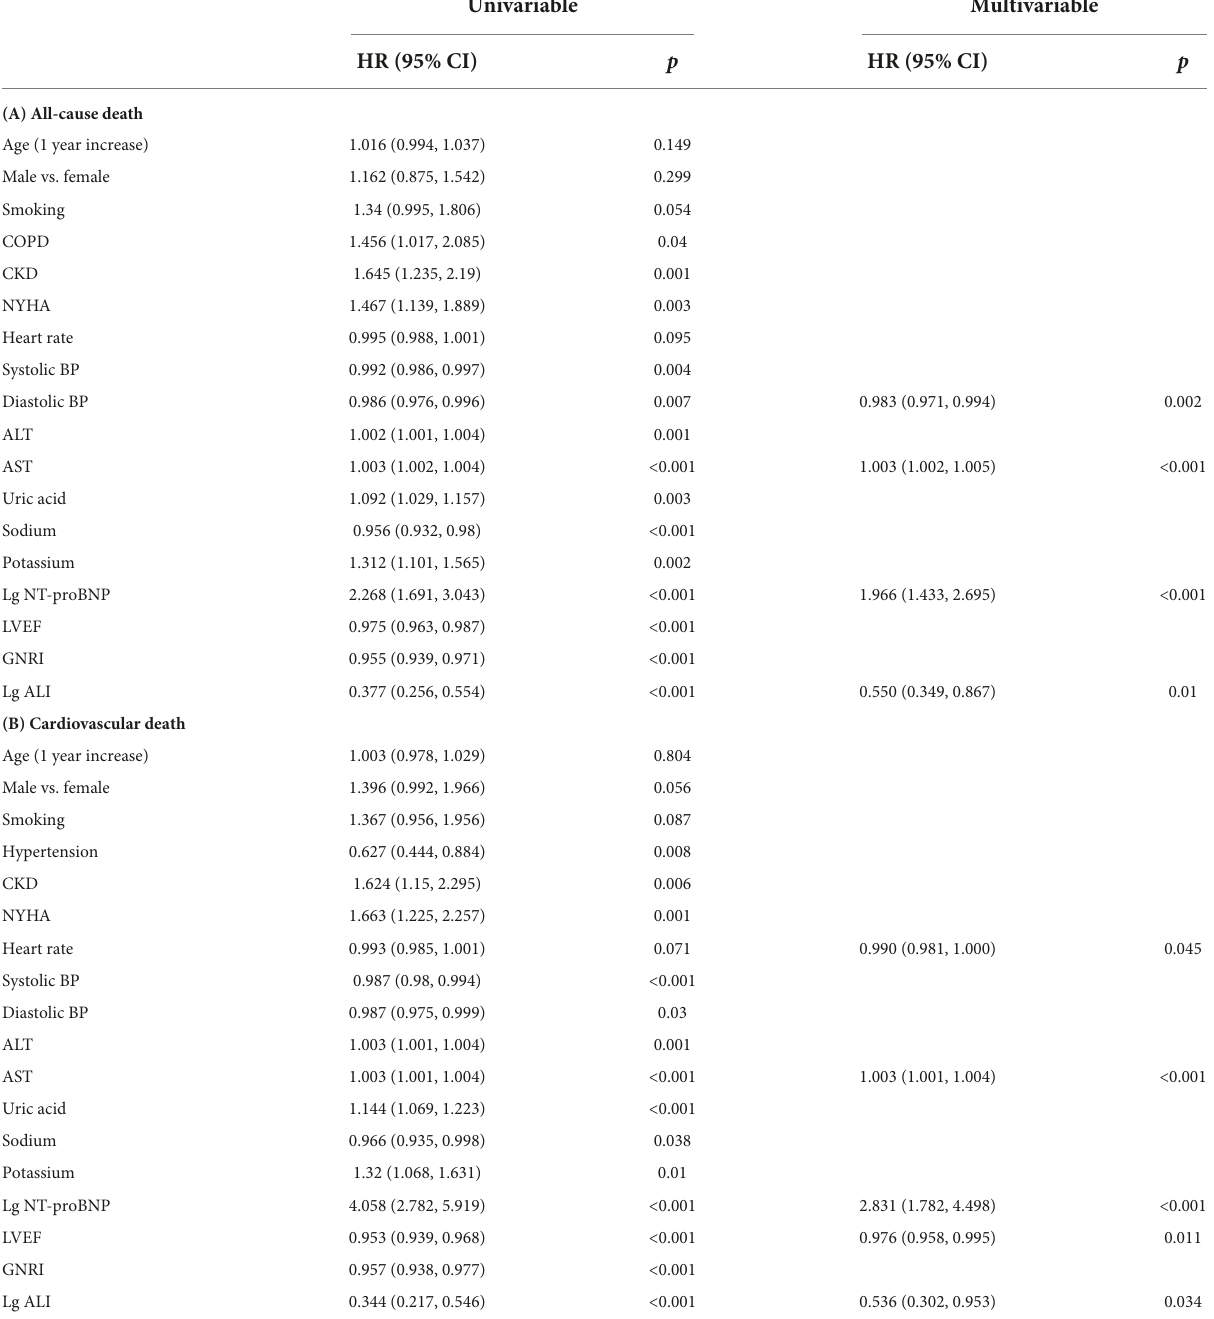
TABLE 2 Results of univariable analysis and final model of multivariable analysis using Cox proportional hazard analysis of all-cause death (A) and cardiovascular death (B)